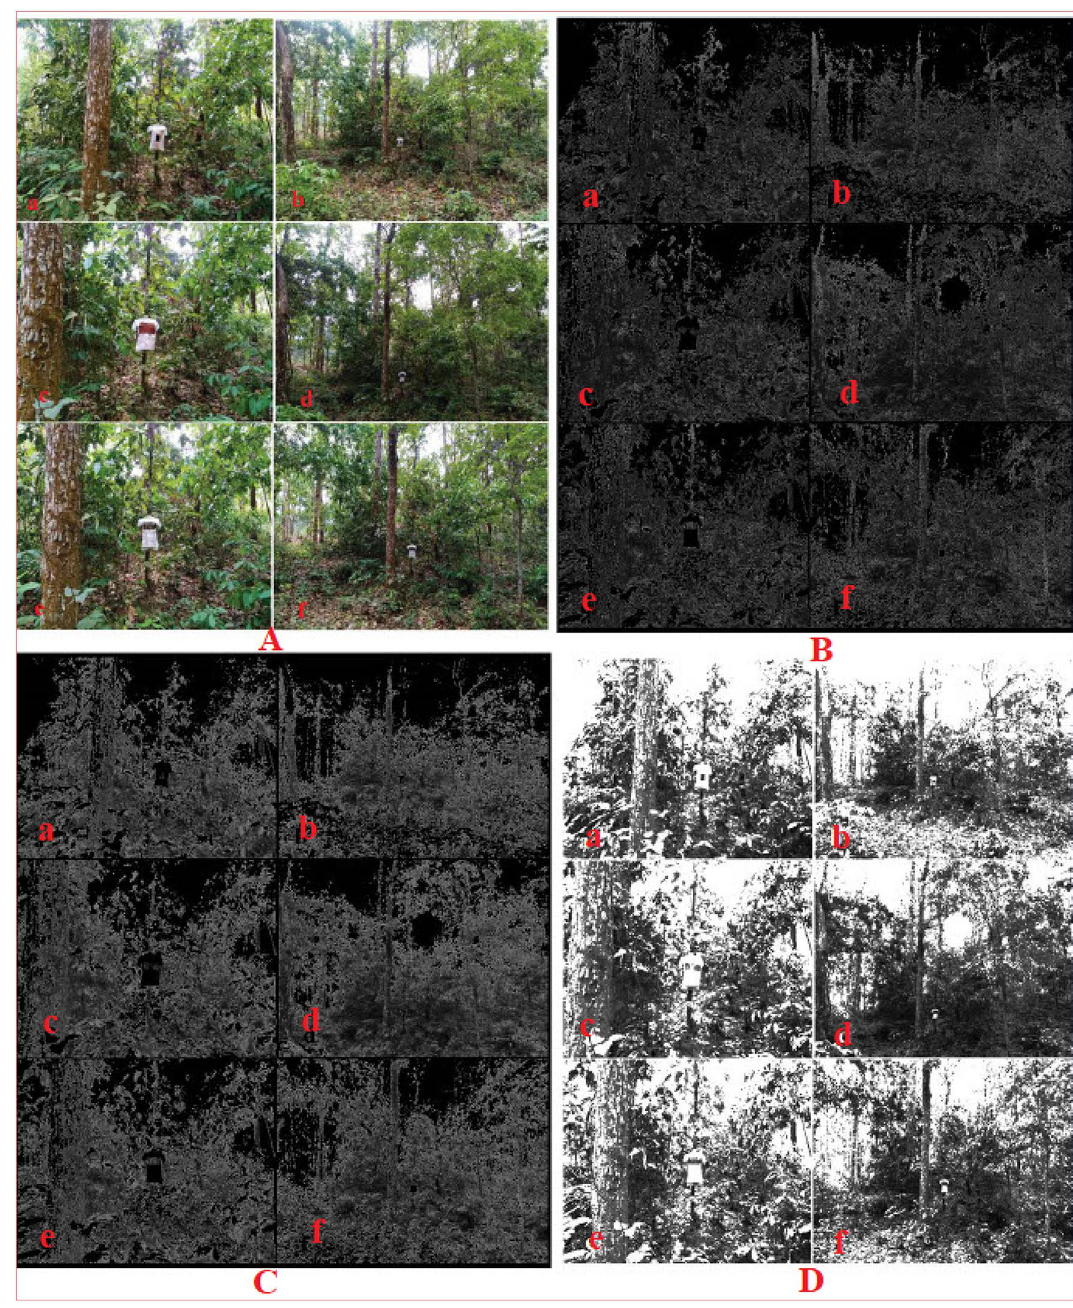
Figure 8. NPND-dyed-coated-printed garments placed against woodland CB and shown the photometric versus colorimetric views of blue ( B ), green ( C ), red ( D ) in grey scale imaging of RGB raw image ( A ) when the pictorial mapping has been engendered as Aa = Ba = Ca = Da; Ab = Bb = Cb = Db; Ac = Bc = Cc = Dc; Ad = Bd = Cd = Dd; Ae = Be = Ce = De; Af = Bf = Cf = Df for chromatic